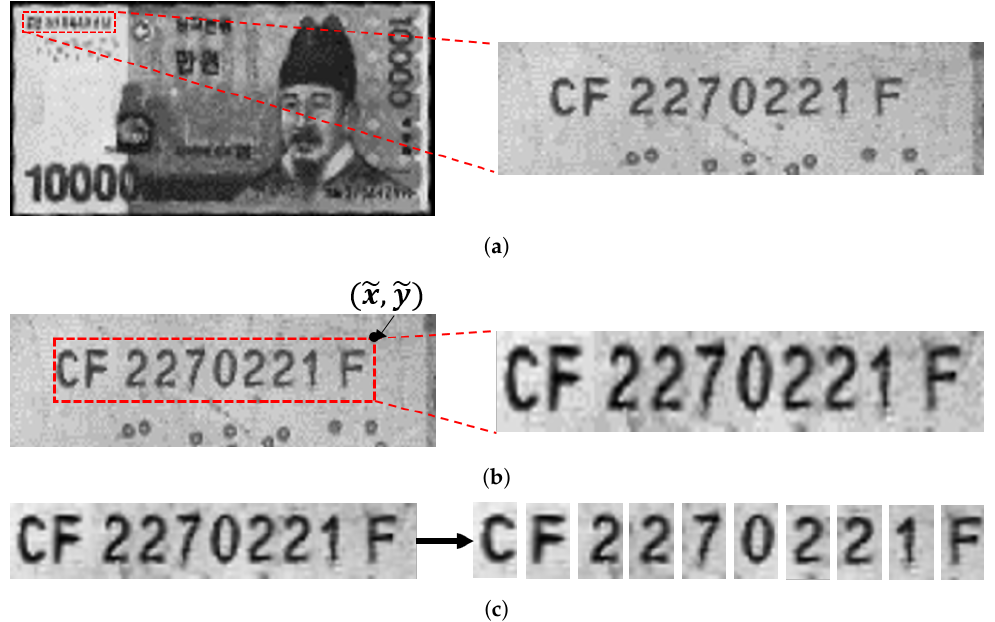
Figure 2. Images of Korean Won and their cropped image. ( a ) Region detection ( b ) ROI detection ( c ) Character